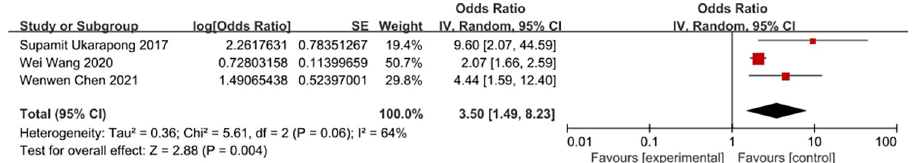
Fig 8. Forest diagram of the relationship between cholestasis and the incidence of MBDP.